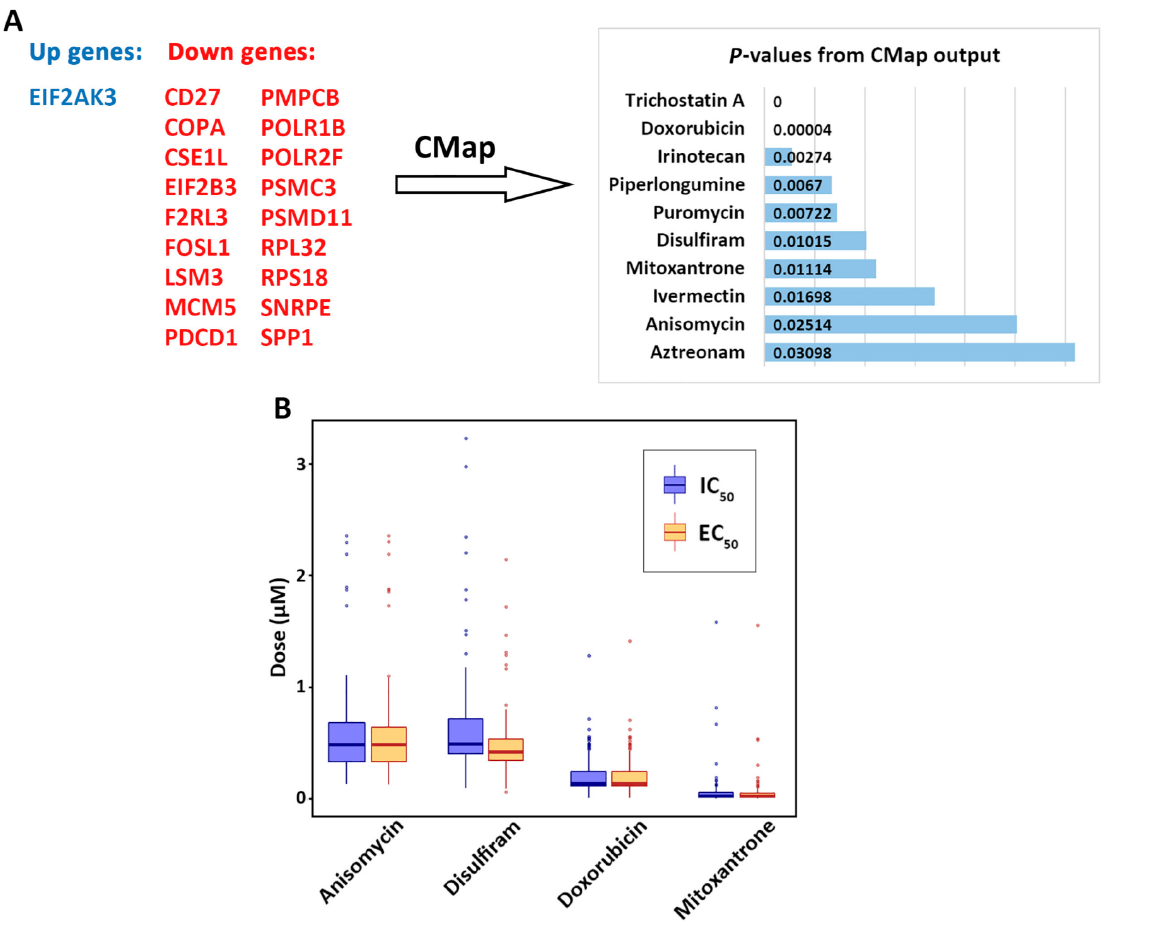
Figure 6. Discovery of repurposing drug candidates. ( A ) Selection of small molecules based on our identified gene expression signature with CMap. ( B ) Small molecules that had a low average concentration of drug response in the CCLE NSCLC cell lines ( n = 117). An outlier, disulfiram EC 50 = 25.645, was excluded from the